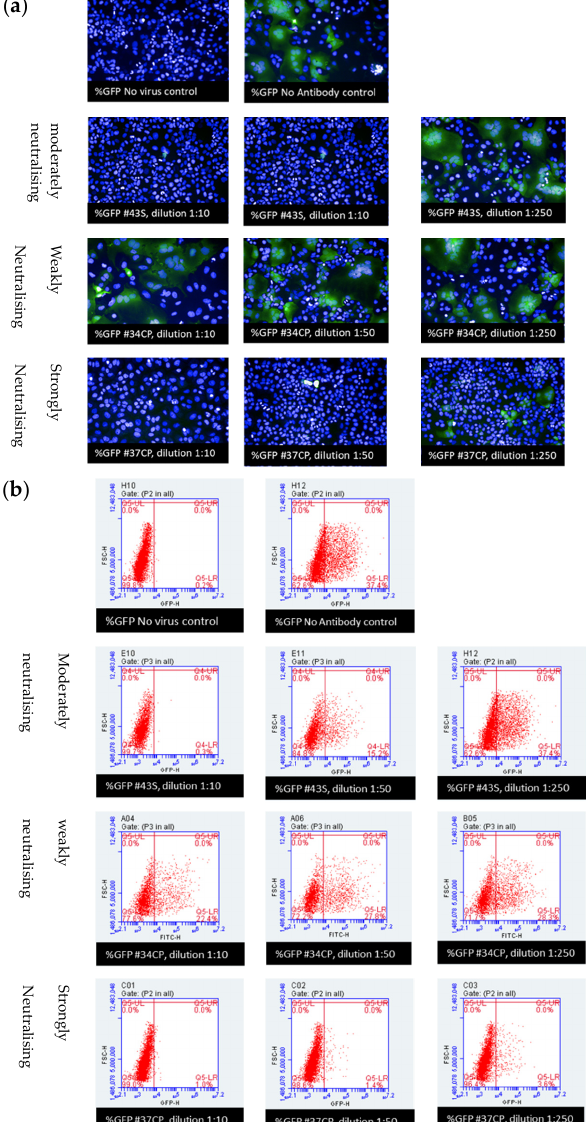
Figure 5. Detection of SARS-CoV-2 S-neutralising antibodies by high-content screening microscopy and FC. The first row shows images of positive controls: nontransduction or negative control (transduction with 200 µL of pseudoviruses without serum). The following rows show the results of the dose dilution response from three serum patient samples: (i) weakly neutralising serum (sample #34CP); (ii) moderately neutralising serum (sample #43S); (iii) strongly neutralising serum (sample #37CP). ( a ) Representative images from HCI showing the results obtained from the neutralisation assay. Nuclei are stained with DAPI (blue); positive transduction cells are detected from the GFP signal (green). One spot represents one cell, and GFP-positive spots correspond to infected cells. ( b ) Representative images from FC showing the results obtained from the neutralisation assay. Numbers in the FC plot indicate the percentage of GFP+ cells in the respective quadrants. Data are from a single experiment representative of three independent experiments.